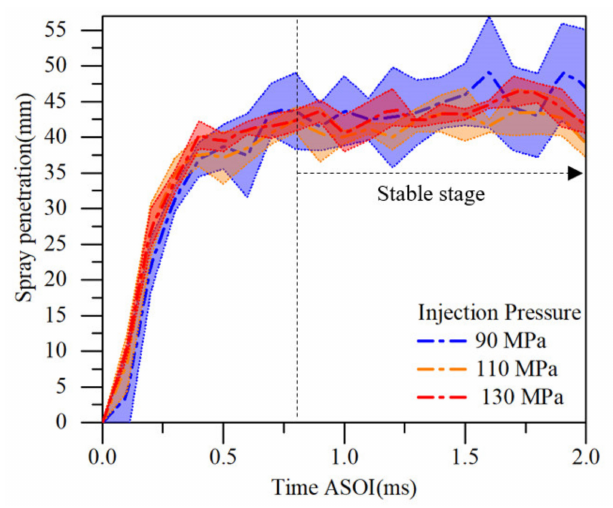
Figure 6. Spray liquid penetration in the experiments.